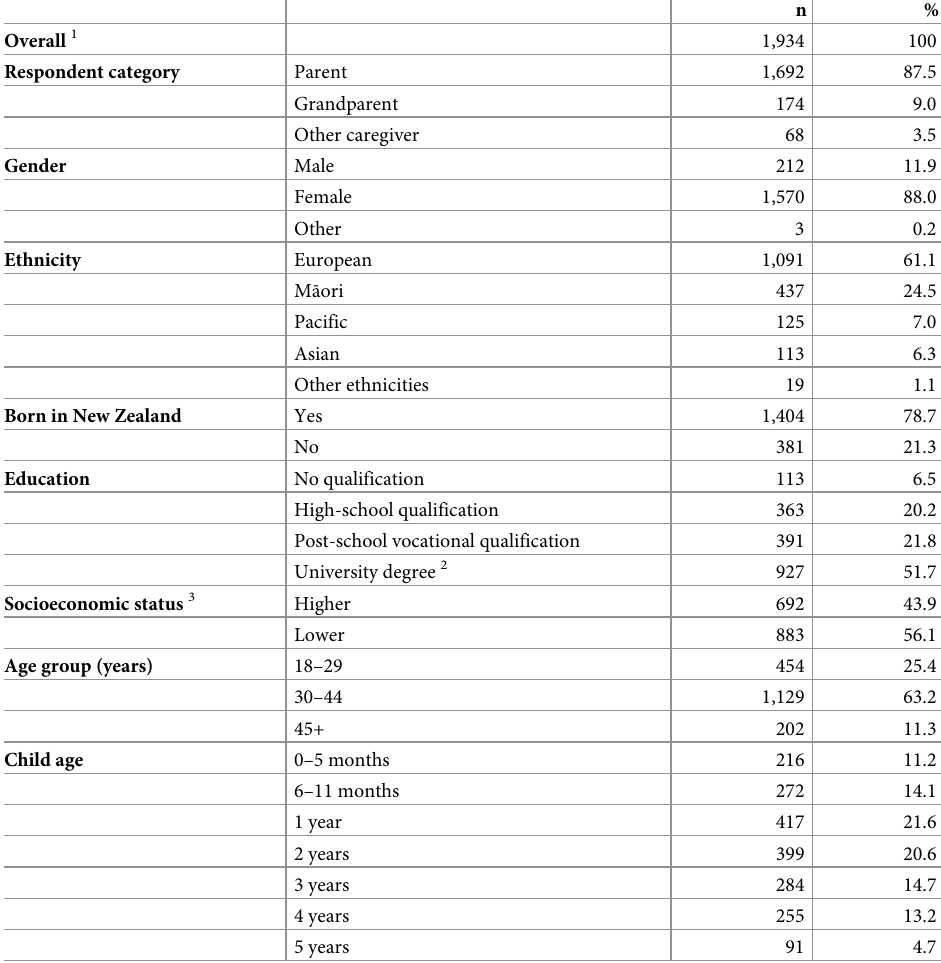
Table 1. Demographic characteristics of questionnaire respondents.